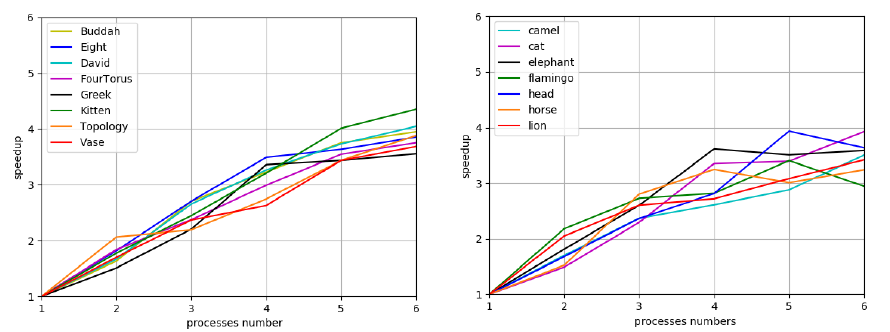
Figure 18. Speedups obtained by our parallel Reeb graph algorithm.